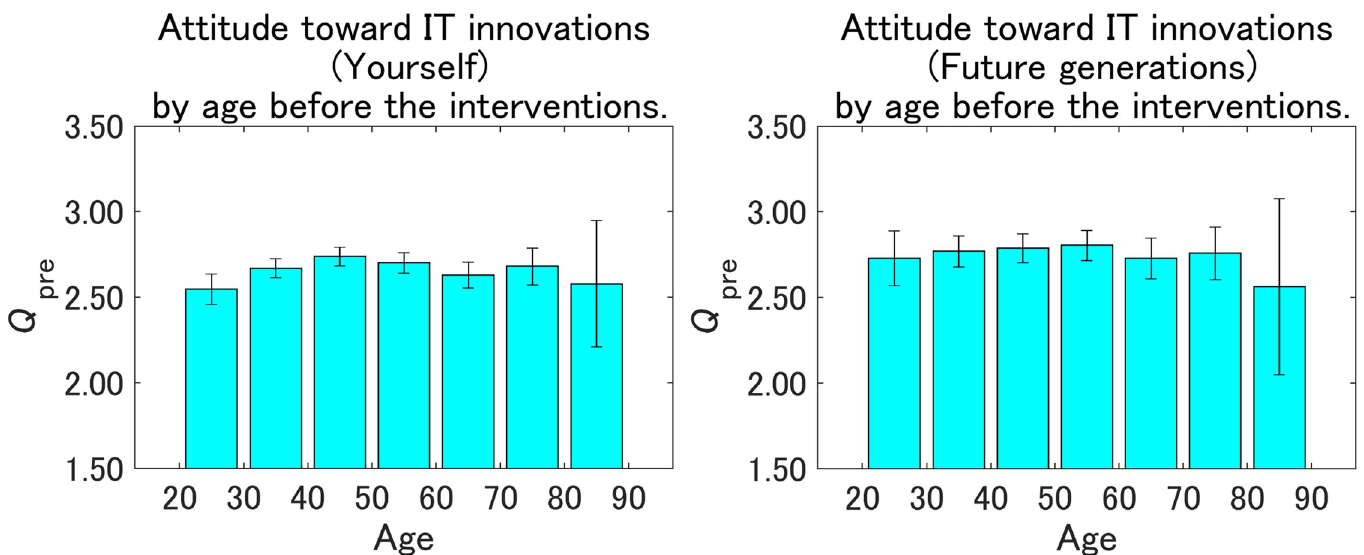
Fig 9. Pre-intervention attitudes toward IT innovations by age. The value on the vertical axis is higher the more dangerous IT innovations are perceived to be. Error bars show 95% confidence intervals.